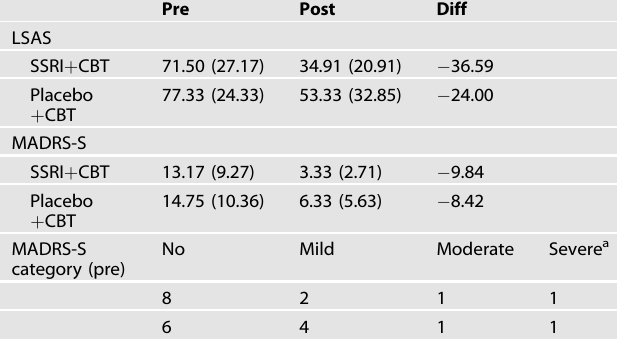
Table 1. Mean (SD) scores of social anxiety (LSAS) and depression (MADRS-S) pre and posttreatment including MADRS-S depression category at